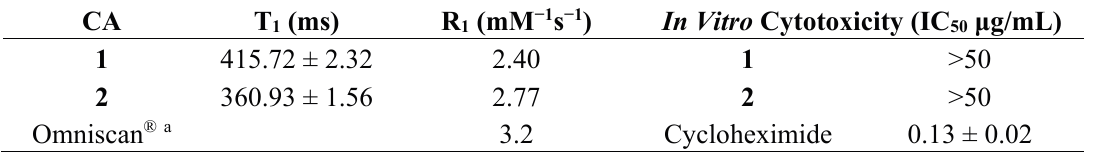
Table 1. Relaxivity and cytotoxicity data of complexes 1 and 2